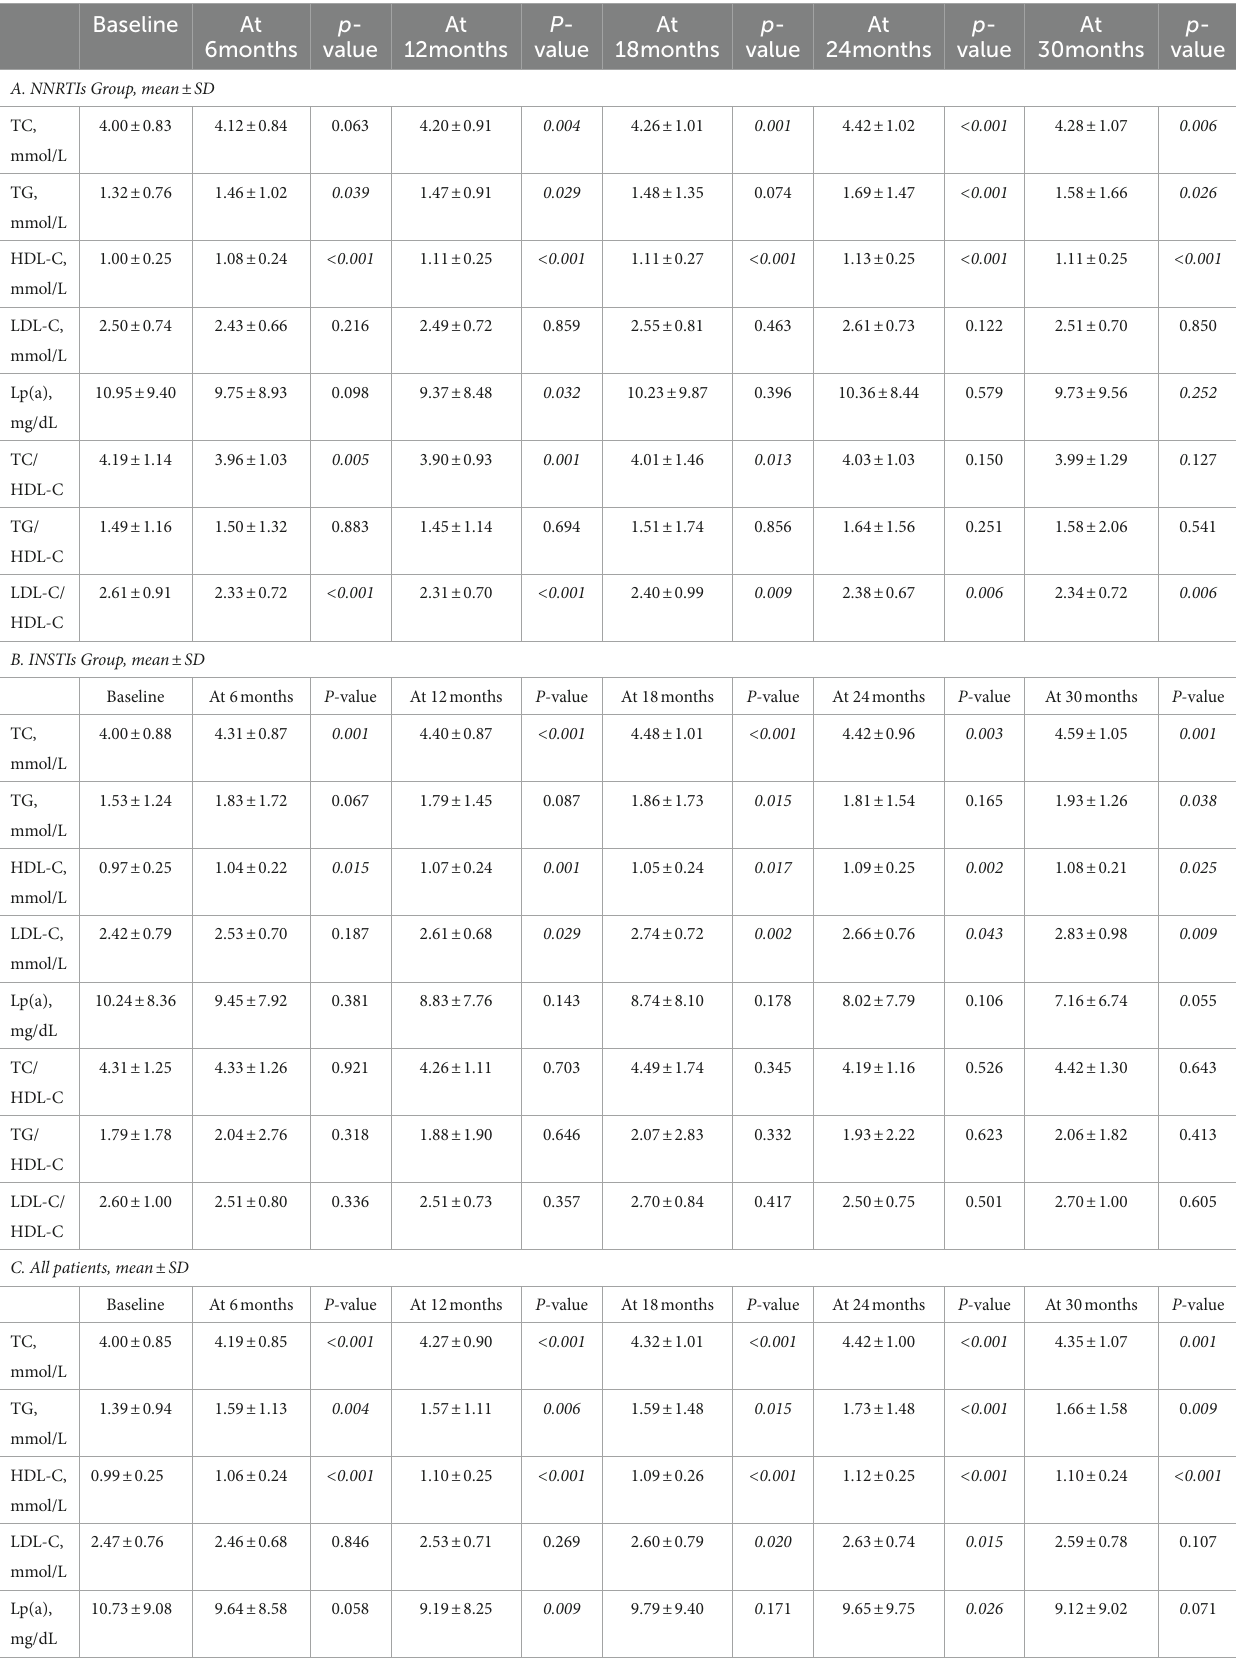
TABLE 2 Comparison of blood lipid levels between baseline data with different follow-up periods by types of ART regimen. Baseline At